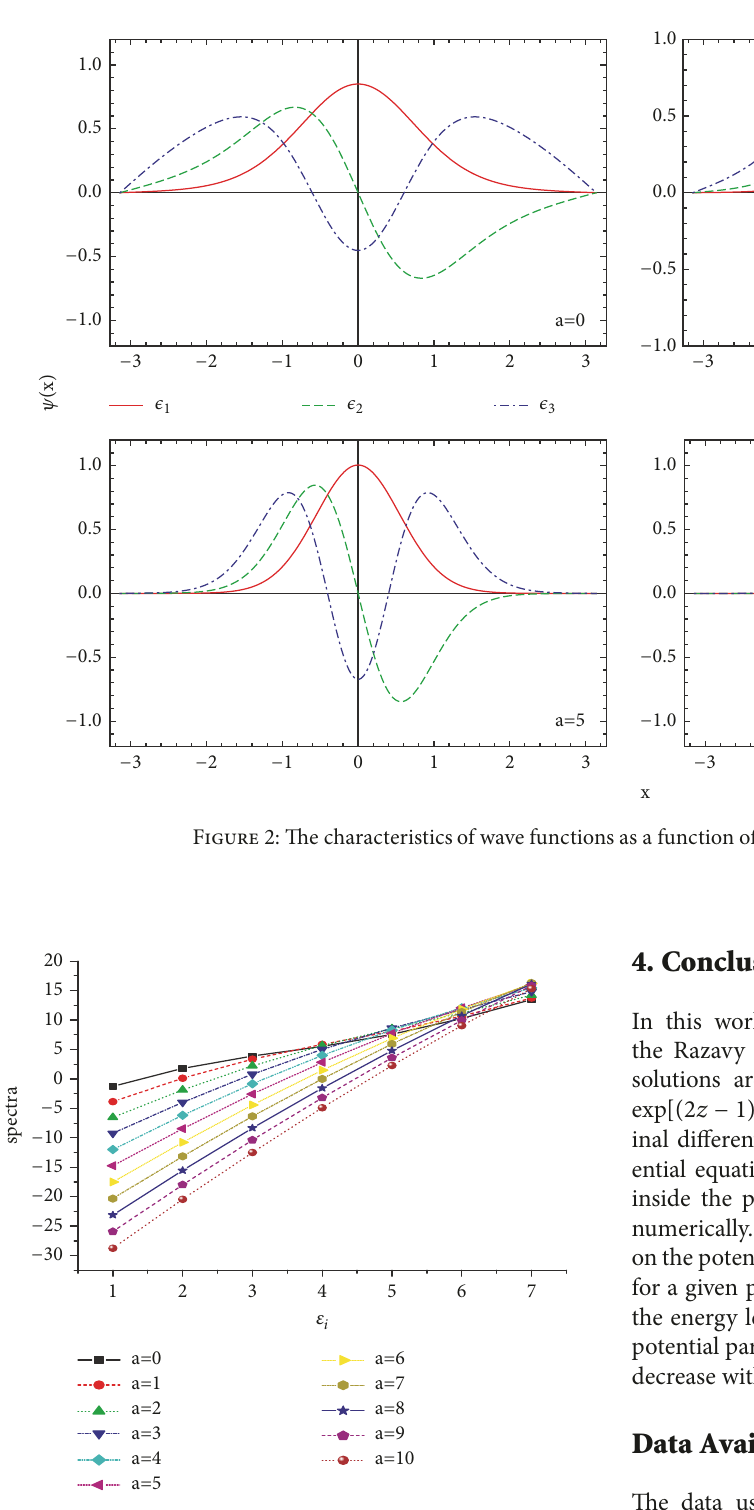
( 𝑖 ∈ [1, 3] ) decrease with the increasing potential parameter 𝑎 but 𝜖 𝑖 ∈ [4, 7] ) first increase and then decrease with the 𝑖 ( increasing potential parameter 𝑎